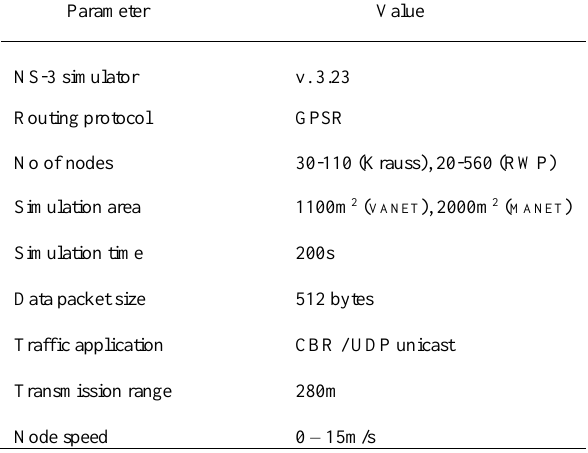
Table 1. Simulation parameters